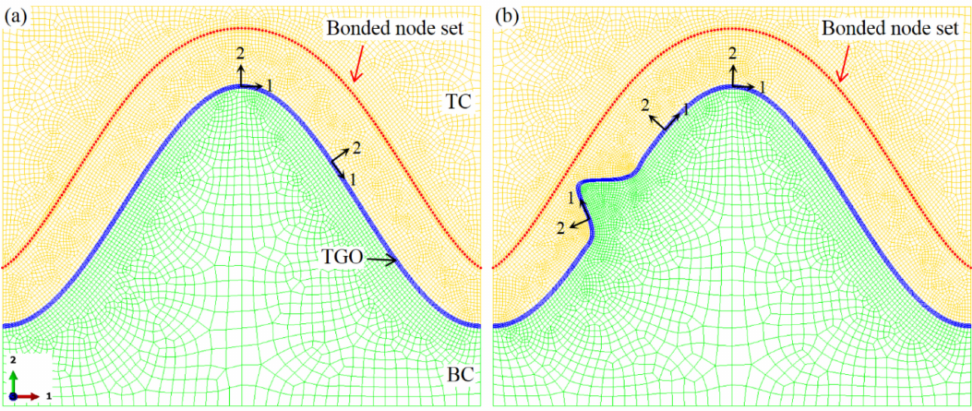
Figure 3. Finite element mesh near the TC/BC interface: ( a ) the mesh near the interface without bulge and ( b ) the mesh near the interface with one